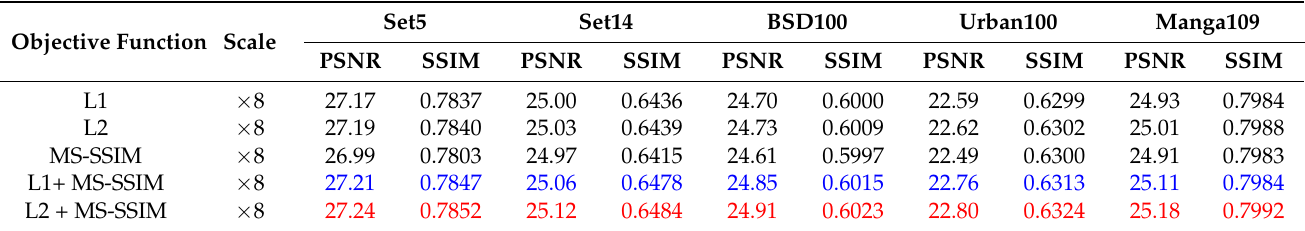
Table 4. Quantitative performance comparison among different objective functions at × 8 scale.